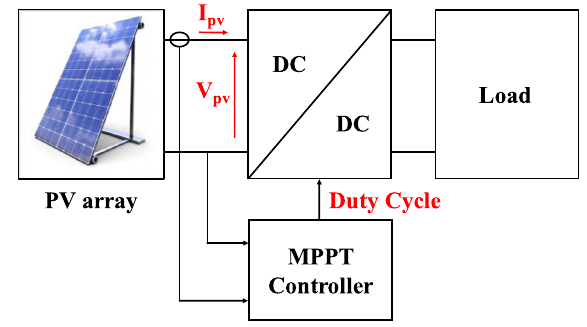
Fig. 1 The used configuration of the PV